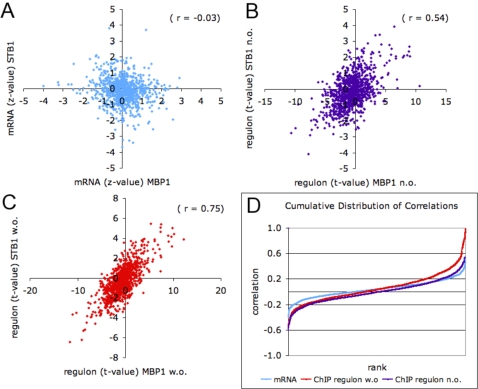
Co-modulation of transcription factors.(A) There is no significant correlation between the normalized mRNA log-ratios (z-scores) over all experiments of the transcription factor genes STB1 and MBP1 (r = −0.03; P = 0.36). (B) By contrast, the inferred activities of the ChIP-based regulons (t-values) of Stb1p and Mbp1p over all experiments are highly correlated (r = 0.53; P<10−12) when overlapping genes are removed (“n.o.” indicates no overlap). (C) As expected, the correlation is even stronger (r = 0.75; P<10−12) when overlapping genes are included (“w.o.” indicates with overlap). (D) Cumulative distribution of pairwise correlations across all transcription factor pairs, for each of the co-modulation detection metrics used in parts A–C, as indicated by the color of the graph.